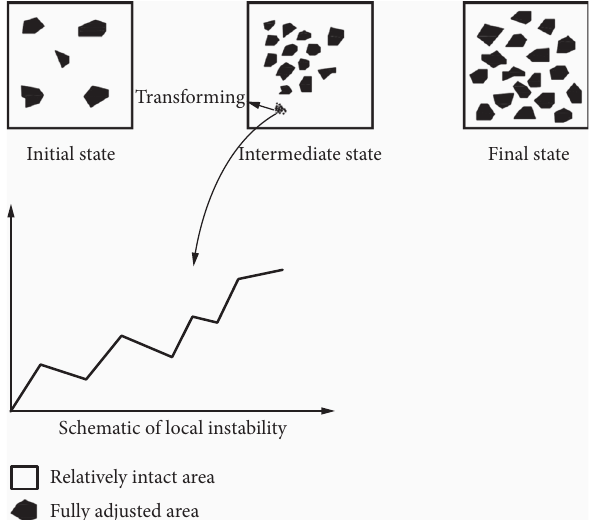
Figure 1: Schematic of the disturbed state